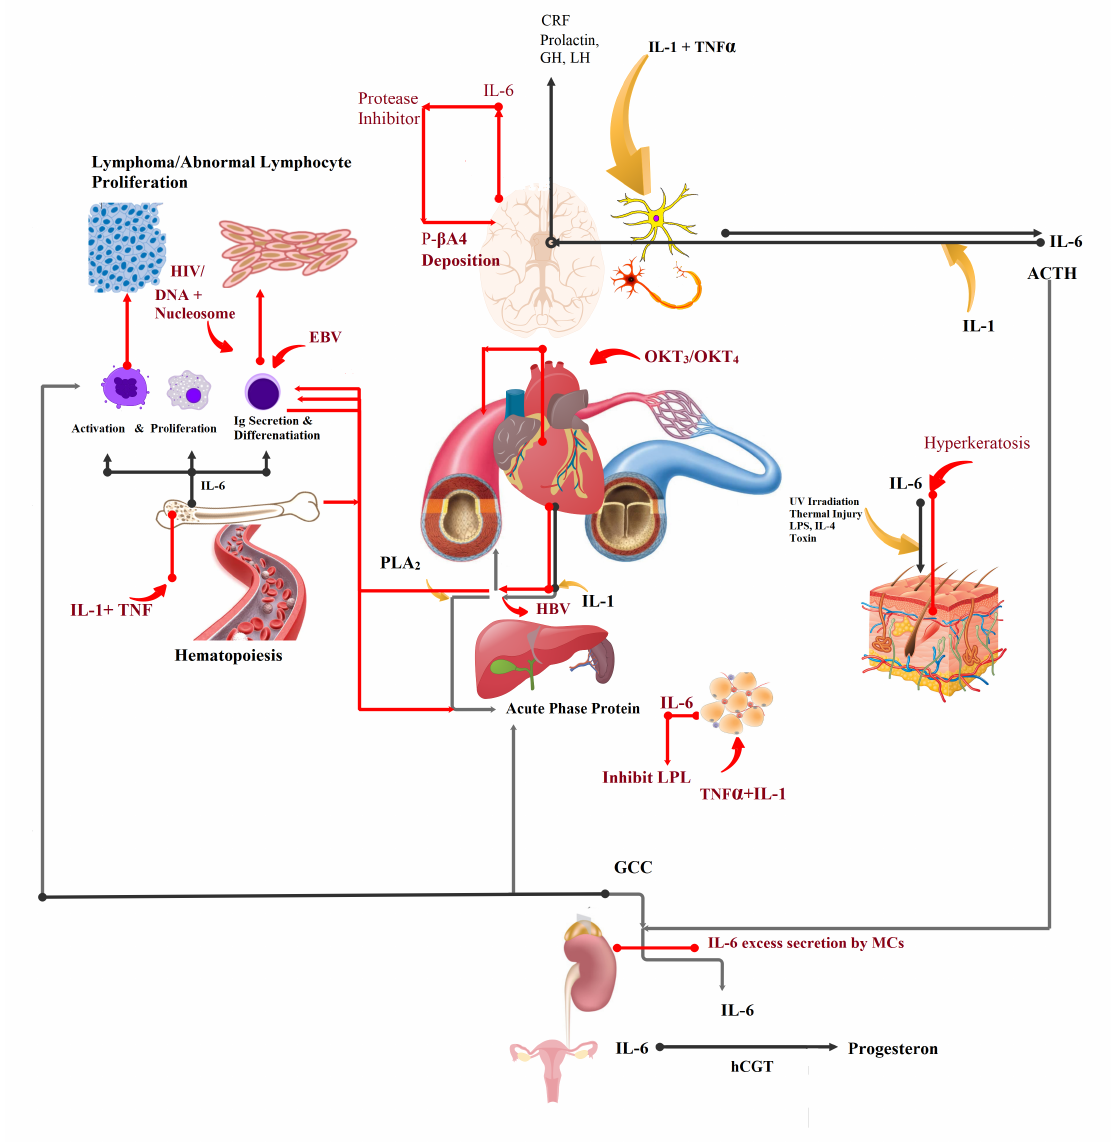
Figure 1. Pleiotropic function of interleukin 6 (IL-6) in humans. Black colored pathway shows normal physiological role, and red-colored pathway indicate impaired functions. CRF = corticotropin-releasing factor; TNF = tumor necrosis factor; LPL = lipoprotein lipase; GCC = glucocorticoid; ACTH = adrenocorticotrophic